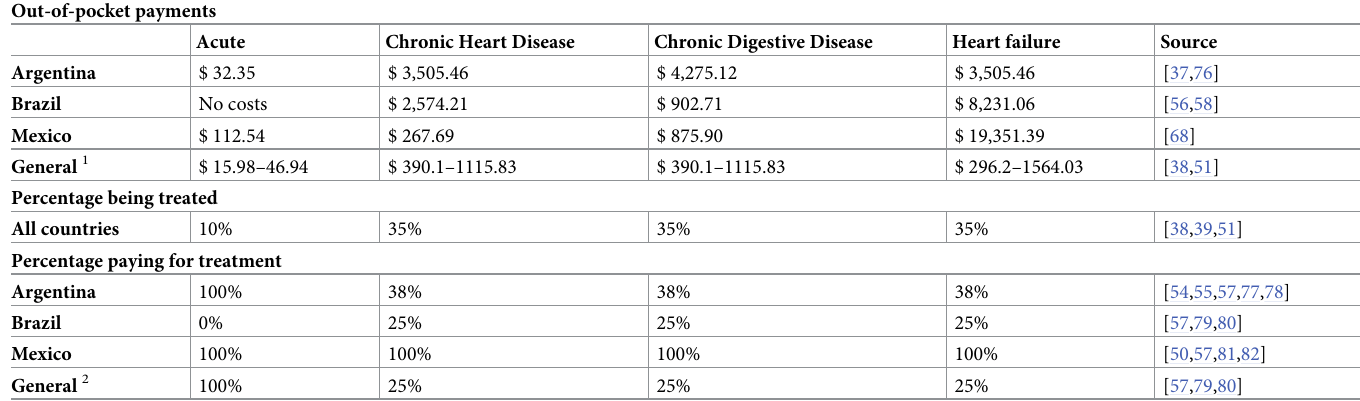
Table 2. Out-of-pocket payments, percentage of patients being treated and percentage of patients paying for treatment according to the literature, used in the cal- culations for Chagas disease (I$—International dollars). Out-of-pocket payments